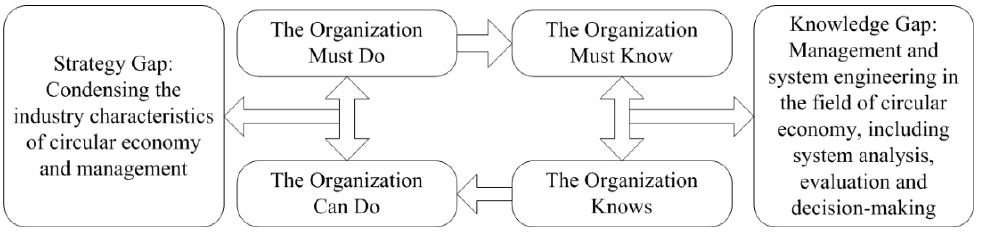
Figure 2. The knowledge gap obtained by SWOT analysis.